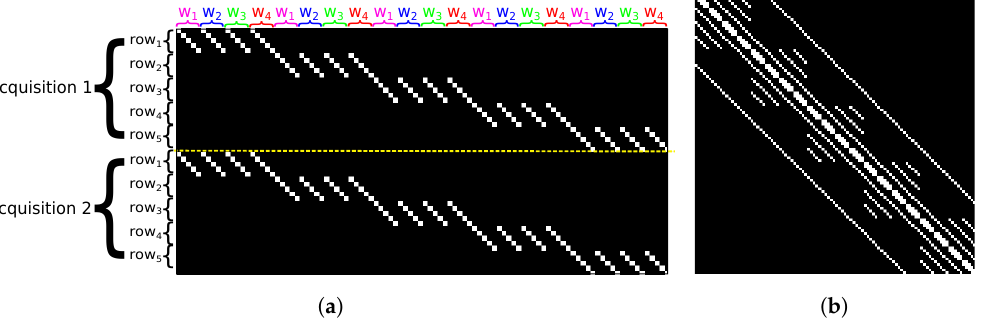
Figure 3. Graphical representations of matrices ( a ) H and ( b ) A in OR, with N = 2, R = 5, C = 5 and W = 4. The white dots represent the non-zero entries. DMD is entirely in transmission state to depict all the possible non-zero entries. The yellow dashed line separates the